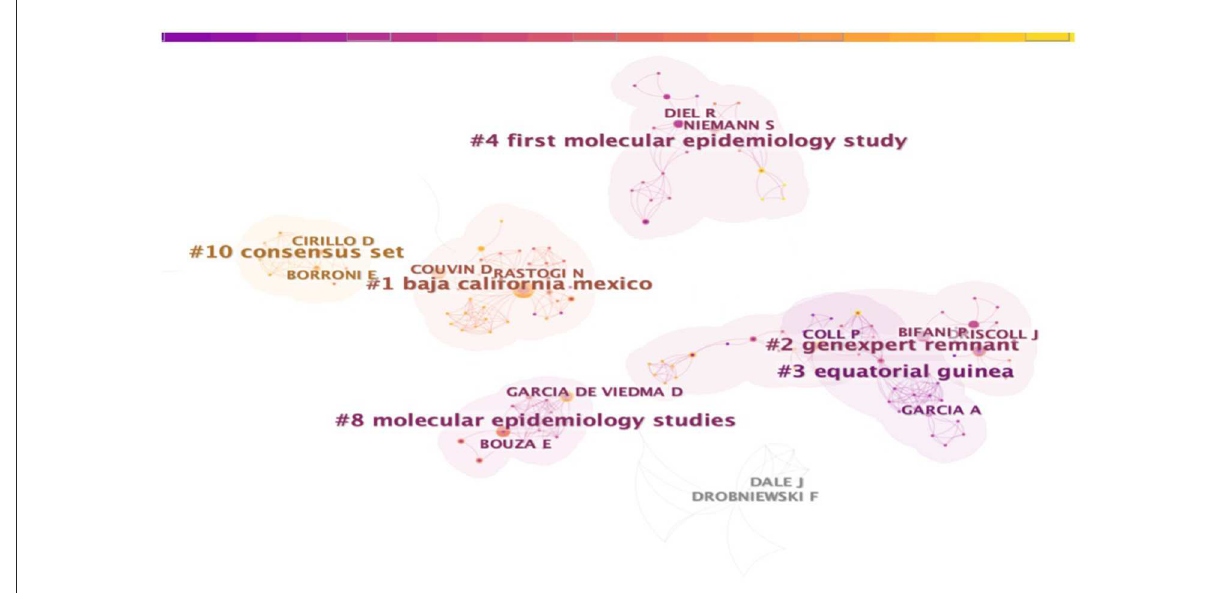
FIGURE2 Clustered network of co-author analysis on tuberculosis molecular epidemiology.